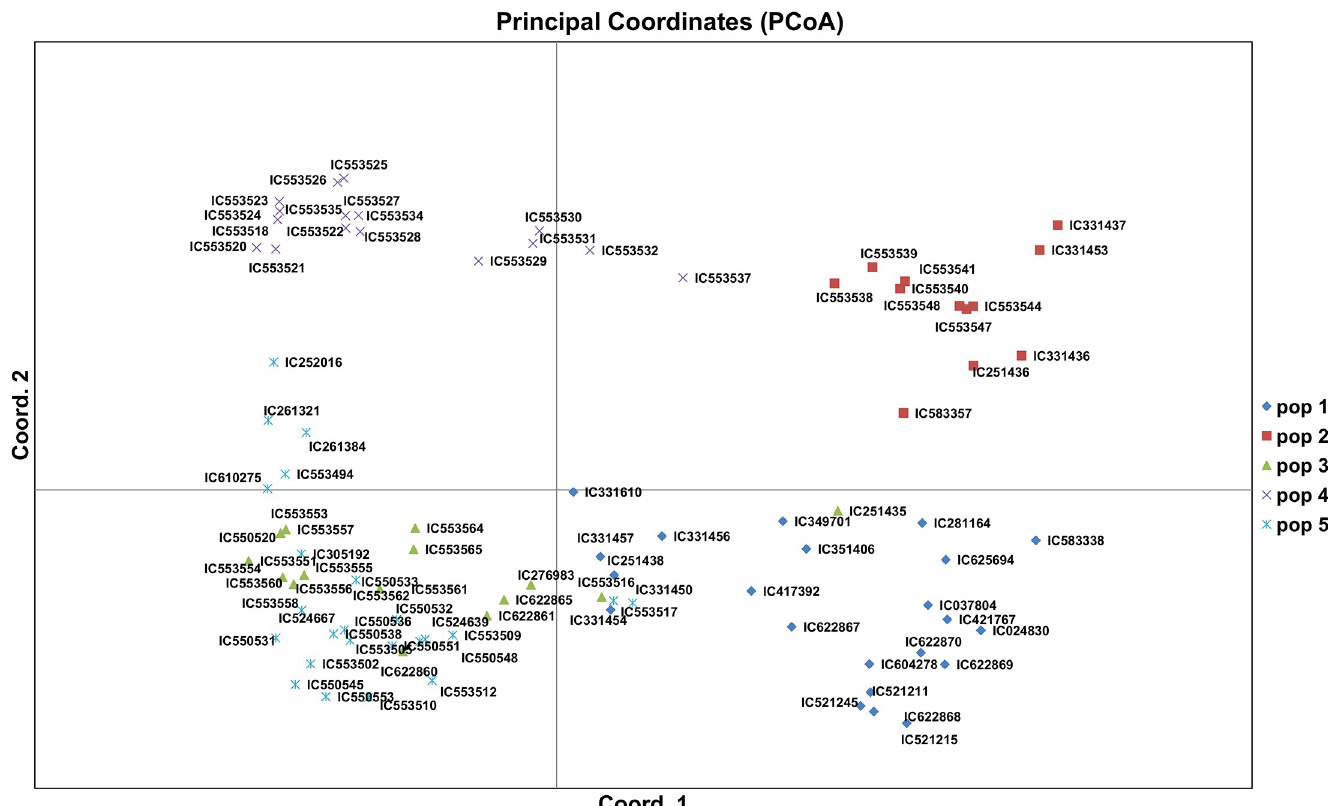
Fig 8. Principal Coordinate Analysis (PCoA) of 94 accessions of V . stipulacea based on 33 SSRs.